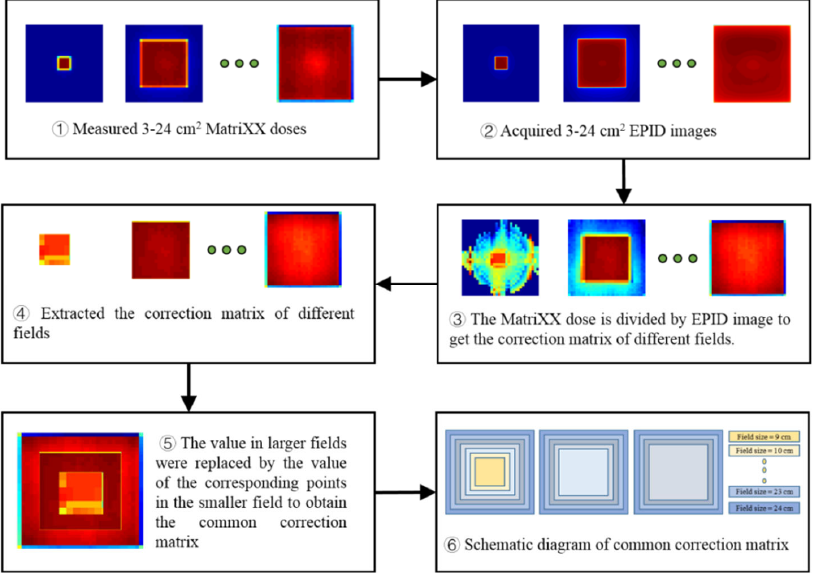
Figure 2. The generation process of the common correction matrix.